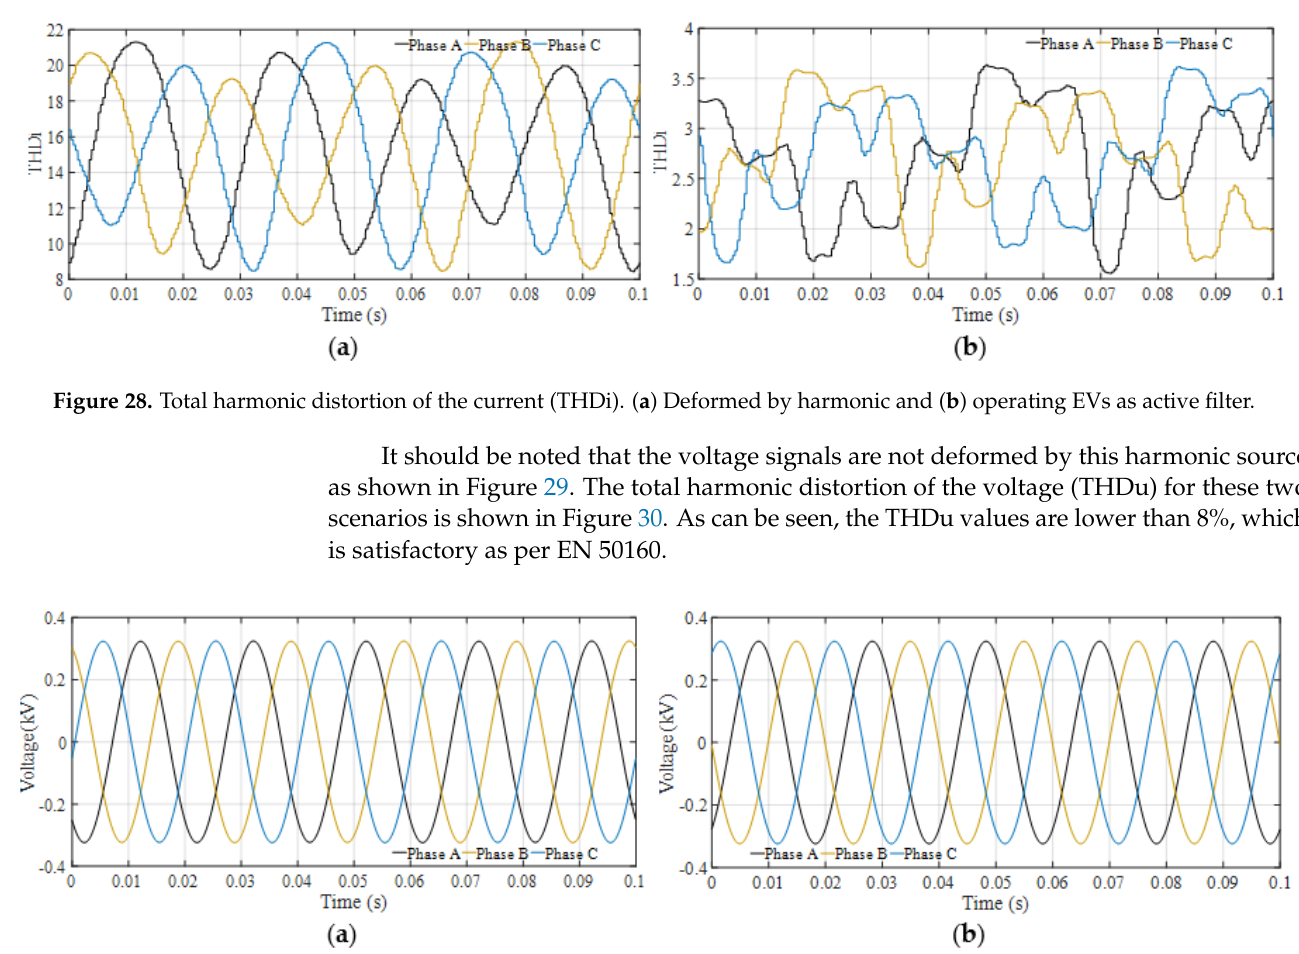
Energies 2021 , 14 , 0 Figure 29. Three-phase voltage signals at the secondary side. ( a ) Affected by harmonic and ( b ) operating EVs as active filter.